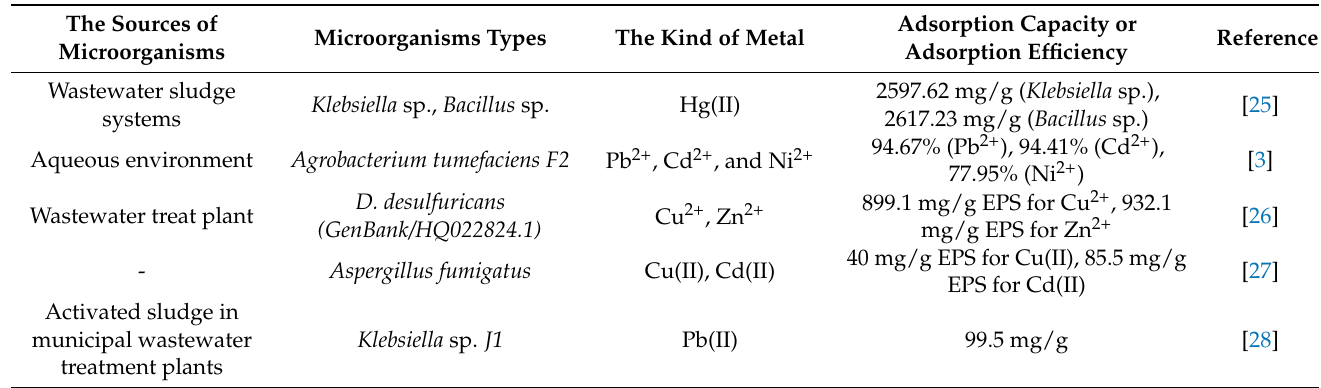
Table 1. Adsorption of heavy metals (HMs) on extracellular polymeric substances